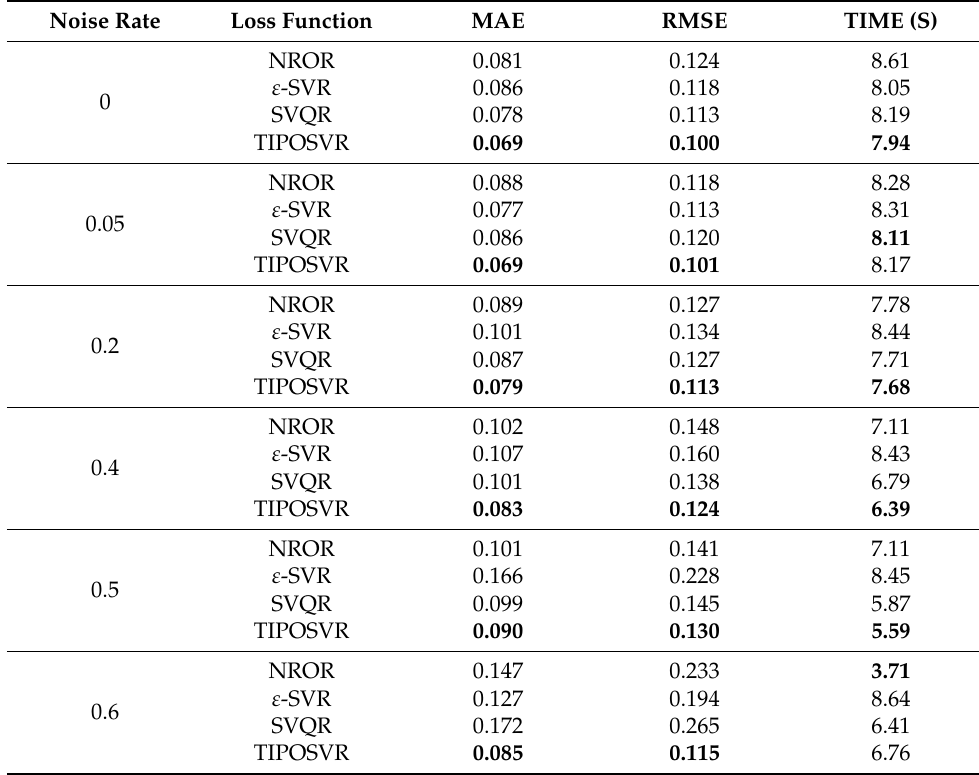
Table 7. Operation results of algorithms under the influence of noise type V for synthetic dataset.